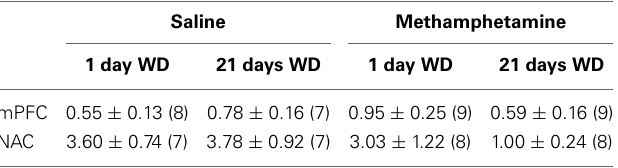
Table 1 | When assayed using conventional in vivo microdialysis procedures, we failed to detect an effect of repeated methamphetamine experience or withdrawal upon basal extracellular dopamine (fg/20 μ l dialysate) within either the mPFC or the NAC.